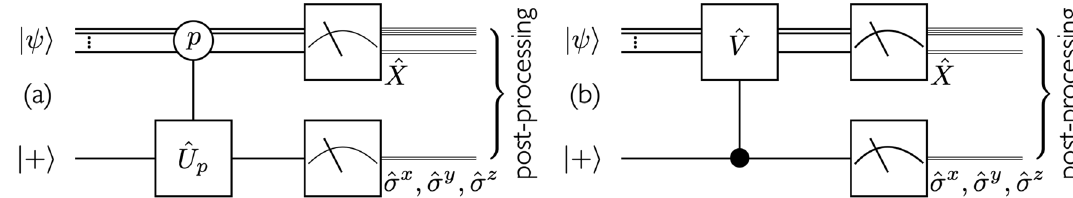
0 0 1 1 e ip θ on the := | � � | + | � � | e i θ ˆ P on :=